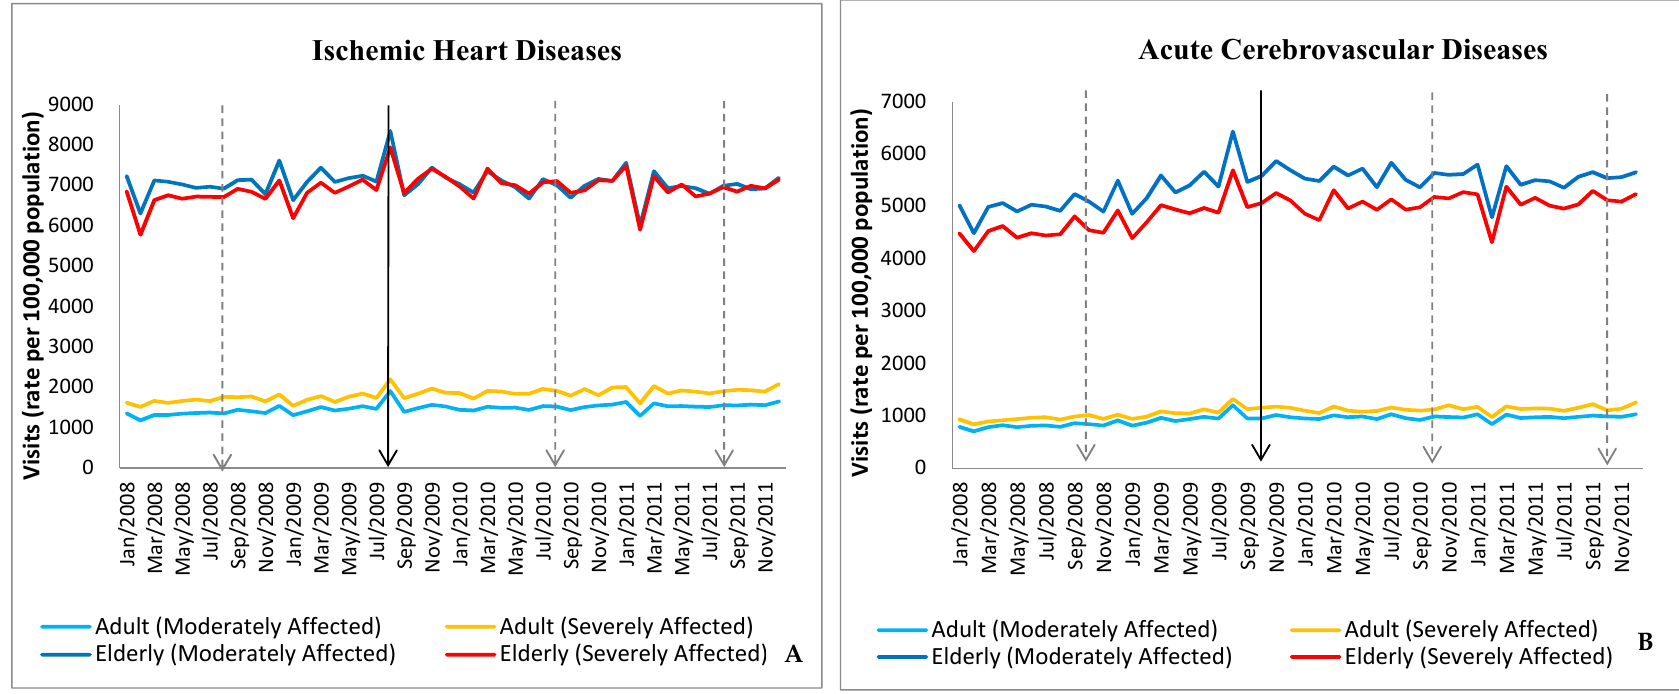
Figure 1. Monthly visits for acute cardiovascular and cerebrovascular events by affected adults before and after Typhoon Morakot. ( A ): Ischemic Heart Diseases; ( B ): Acute Cerebrovascular Diseases. Vertical solid lines: Index Month (August/2009); vertical dotted lines: August/2008, August/2010 and August/2011.